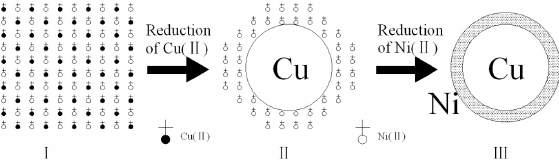
Figure 2: Illustration of the ideal formation process of the Cu-Ni composite particles: step , Cu (II) and Ni (II) co-existence; step , reduction of Cu (II); step III, reduction of Ni (II).